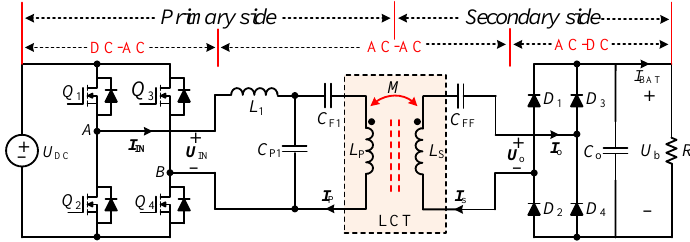
Figure 6. LCC-S compensated WPT charging systems.